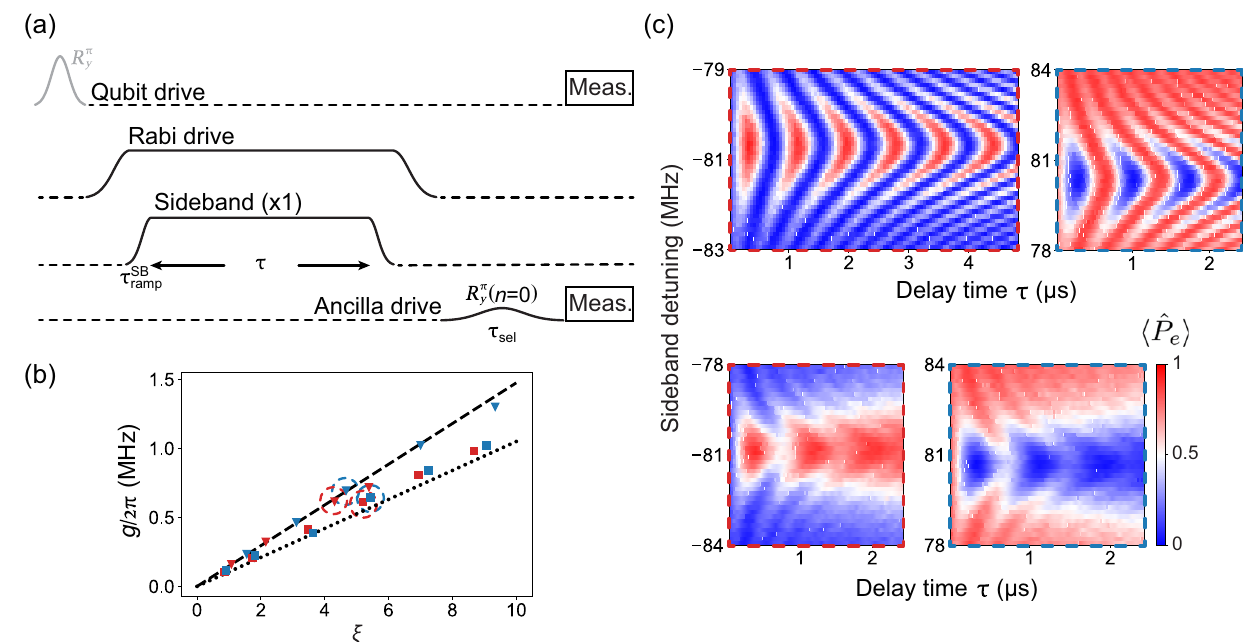
FIG. 9. Calibrating individual exchange interactions. (a) Pulse sequence. The transmon is initialized in either j g i or flipped to j e i with a π rotation depending on if the red or blue sideband is activated. The sideband is turned on with a ramp time τ SB Δ ω − ω is the detuning from the sideband to the Stark-shifted cavity frequency. A frequency selective π rotation of the ancilla c SB ¼ pump qubit maps the vacuum projector of the tuning mode onto the state of the ancilla, which is subsequently measured with the qubit simultaneously. (b) Interaction strengths g for individual sideband interactions between the driven qubit and the tuning mode (triangles) or coupling mode (squares). g is extracted via a fit using Eq. (D4) for the red sidebands (red markers) and blue sidebands (blue markers). Error bars are smaller than the markers. ξ is calibrated via independent measurements of χ pump amplitude. Dashed and dotted lines represent the expected interaction strength in the ideal case g ¼ χ coupling modes, respectively. Deviations of the data from a linear relation for the tuning mode coincides with regions where the Stark shift becomes nonlinear in pump power. Slight disagreement between the data and theory expectation for the coupling mode may stem from an inaccurate estimate of χ and from a sensitivity of the extracted fit values to a true value of κ b qubit population for a fixed pump amplitude [dashed circles in (b)] for the tuning mode (top) and coupling mode (bottom). The sideband detunings are referenced to the cavity frequencies, showing that we are operating at Rabi frequencies Ω